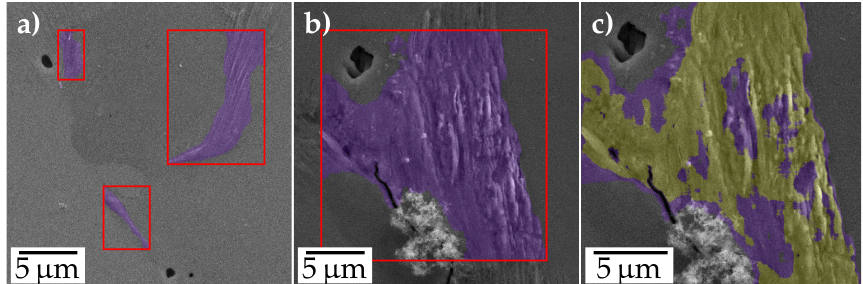
Figure 4. Extrusion images extracted using the extrusion masks from semantic segmentation for two example images ( a , b ), and the extrusion image from ( b ) overlaid with a thresholded extrusion probability mask ( c